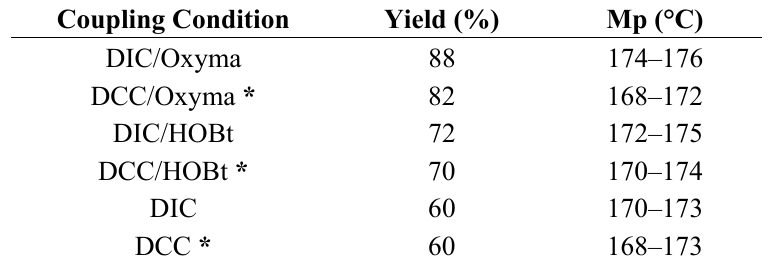
Table 1. Reaction of 3 with H-Ala-OMe.HCl using various coupling